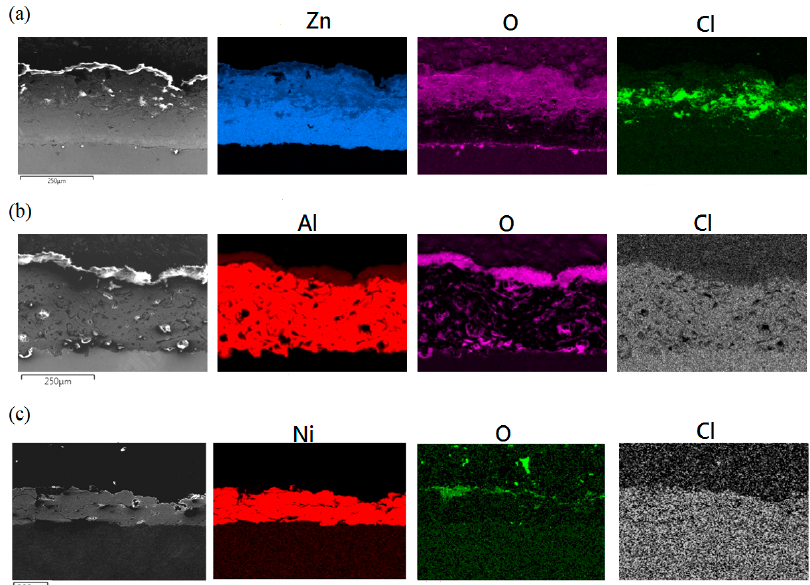
Figure 4. Cross-sectional EDS image of the ( a ) ZnAl, ( b ) Al and ( c ) Inconel 625 coatings after 1000 h of immersion corrosion.